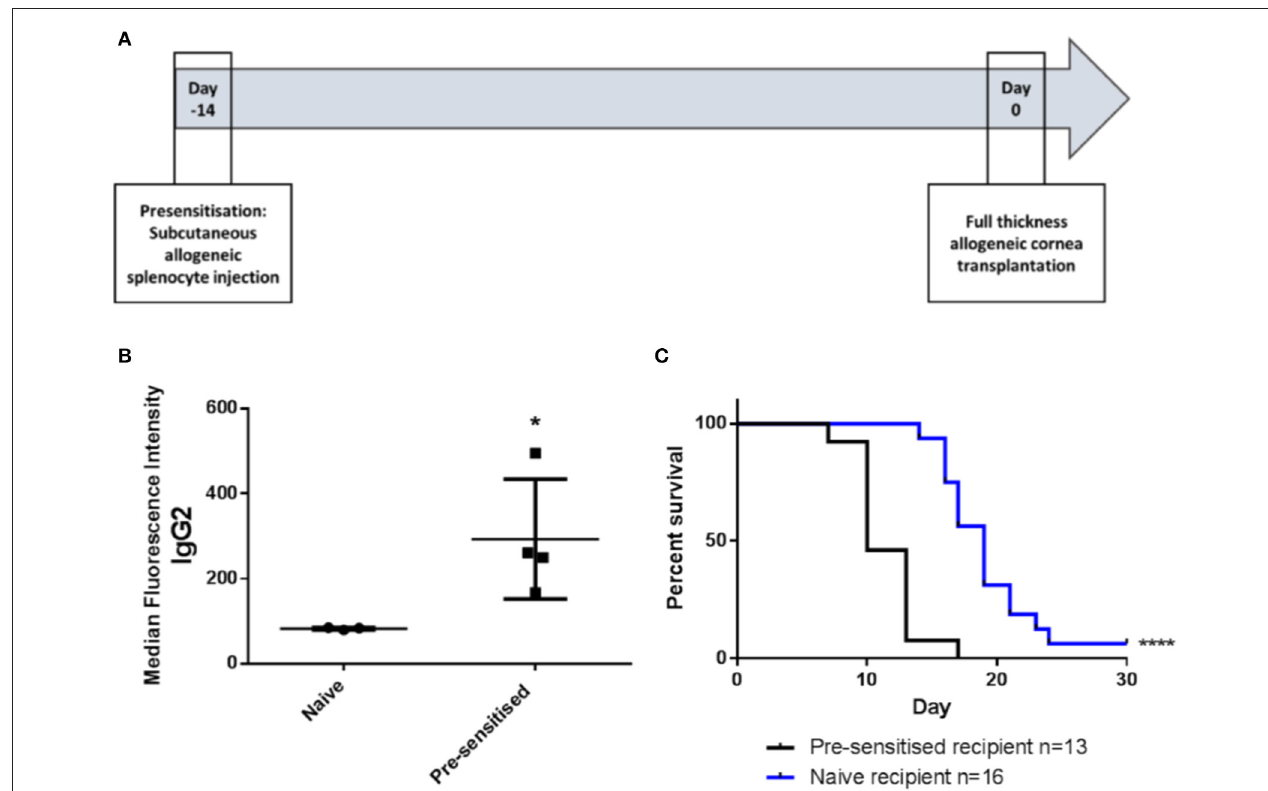
FIGURE 1 | DA-splenocyte pre-sensitized Lewis rats develop anti-DA IgG antibodies and reject corneal allografts earlier than non-pre-sensitized Lewis rats. (A) Lewis rats were pre-sensitized with 10 × 10 6 DA rat (donor) splenocytes 14 days prior to cornea transplantation. (B) Graph showing results of flow cytometry analysis of DA rat splenocytes incubated with serum samples taken at the time of transplantation from non-pre-sensitized (naïve; n = 3) and pre-sensitized ( n = 4) Lewis rats followed by staining with anti-rat-IgG2-FITC. Individual results (symbols) and mean ± SEM for the two groups are shown and expressed as median fluorescence intensity on the FL1 channel. (C) Kaplan-Meier plots depicting DA to Lewis rat corneal allograft rejection-free survival in naïve ( n = 16; blue line) and pre-sensitized ( n = 13; black line) animals. Statistical significance was determined using a one tailed Student’s t -test (B) or Log-rank (Mantel-Cox) test (C) as appropriate * p < 0.05, **** p <